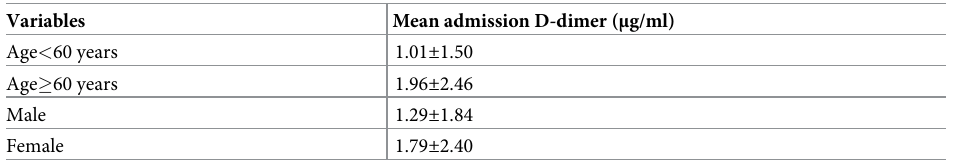
Table 2. Admission D-dimer values based on age and